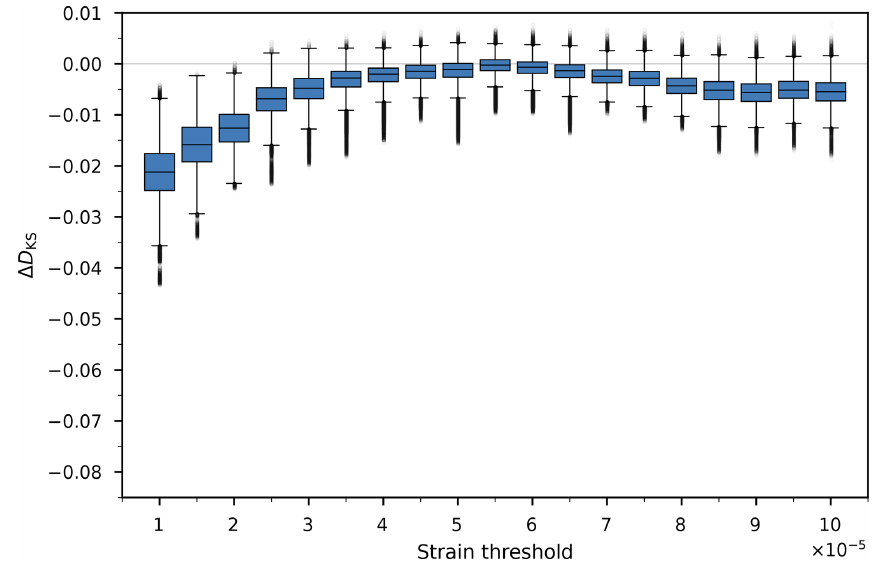
Figure D3. Same as Fig. D1 for varying strain